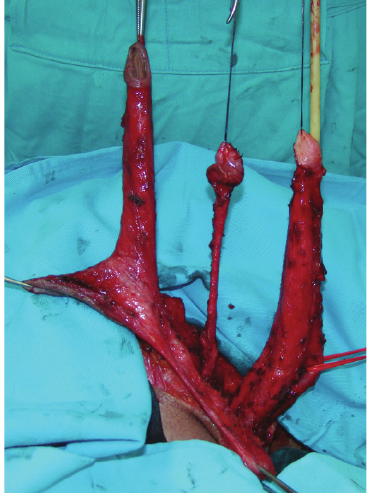
Figure 3: Penile disassembly is done. Conically shaped clitoris with preserved neurovascular bundle is